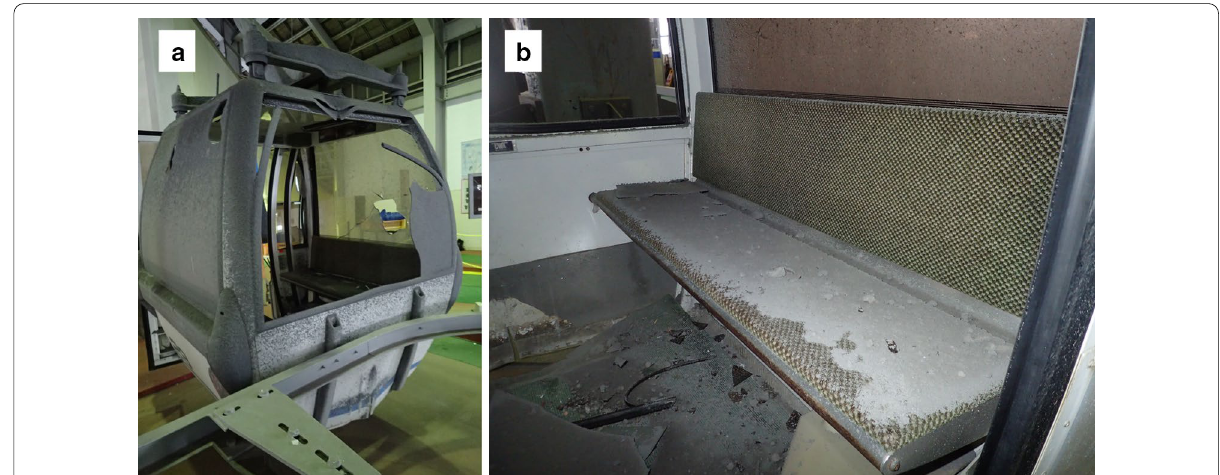
Fig. 4 Photographs of a a damaged cable car (no. 29) by ballistic ejecta, and b primary tephra deposits covering the seat in the car